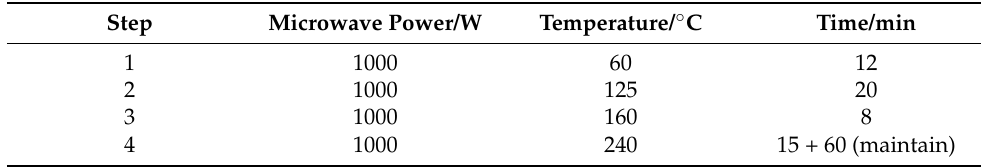
Table 2. Microwave program for the CFA sample